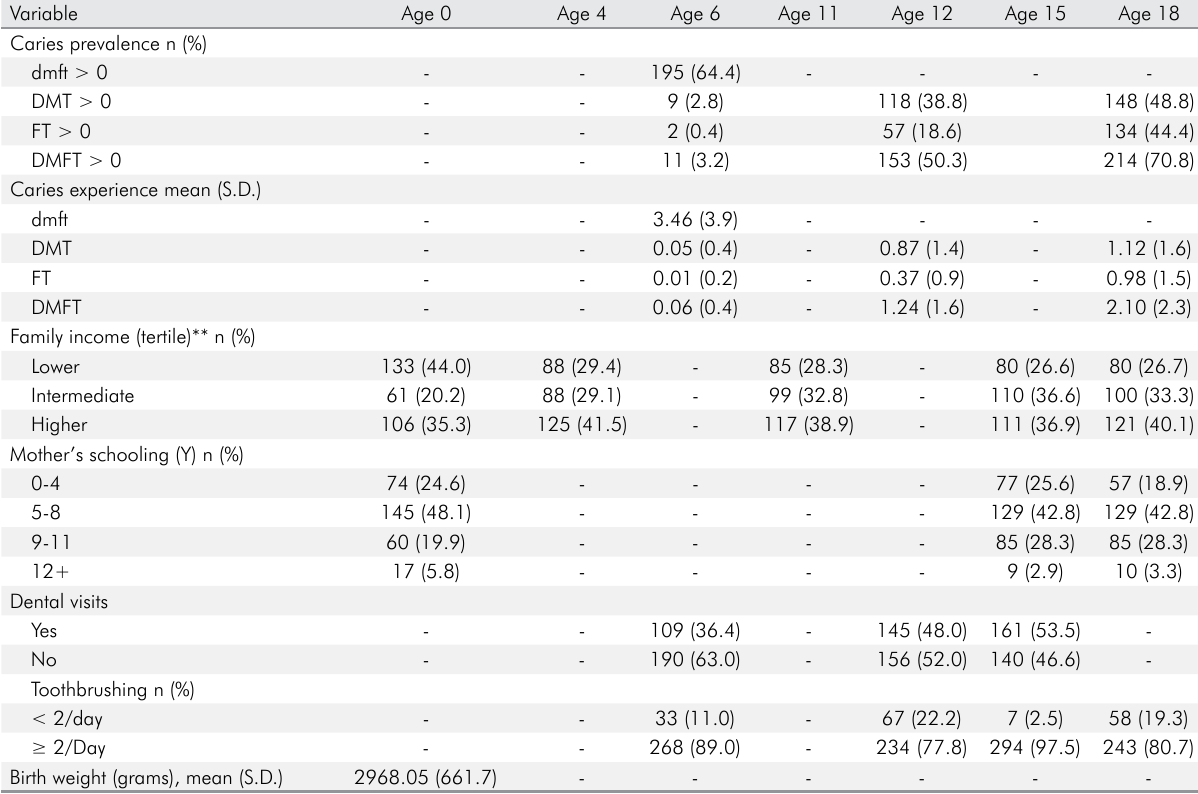
Table 1. Sample characteristics studied in each wave.*